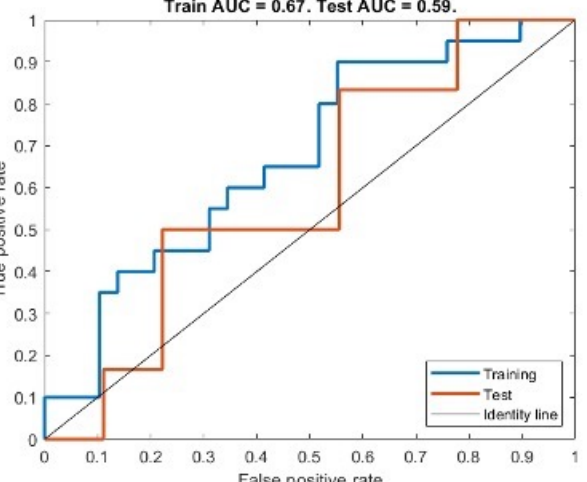
Table 7. LVSI Confusion matrix of Training sets and Testing sets: in the upper left rectangle the true Figure 6. Statistically significant features which can individually assess the LVSI +or -. We report Figure 6. Statistically significant features which can individually assess the LVSI + or − . We report high risk is noted, in the upper right rectangle the false high risk is noted, in the lower left rectangle the number of statistically significant features after correction for multiple comparison divided by the number of statistically significant features after correction for multiple comparison divided by the false low risk is noted, in the lower right rectangle the true low risk is noted. class types and modality. Blue refers to features obtained from T2w images; orange refers to features class types and modality. Blue refers to features obtained from T2w images; orange refers to features extracted from ADC maps. The features belong to the following class types: first-order features, Training set 1 Testing set 1 extracted from ADC maps. The features belong to the following class types: first-order features, Gray Gray Level Cooccurence Matrix (glcm), Gray Level Dependence Matrix (gldm), Gray Level Run Level Cooccurence Matrix (glcm), Gray Level Dependence Matrix (gldm), Gray Level Run Length Length Matrix (glrlm), Gray Level Size Zone Matrix (glszm), Neighbouring Gray Tone Difference Matrix (glrlm), Gray Level Size Zone Matrix (glszm), Neighbouring Gray Tone Difference Matrix Matrix (ngtdm), shape. (ngtdm), shape.